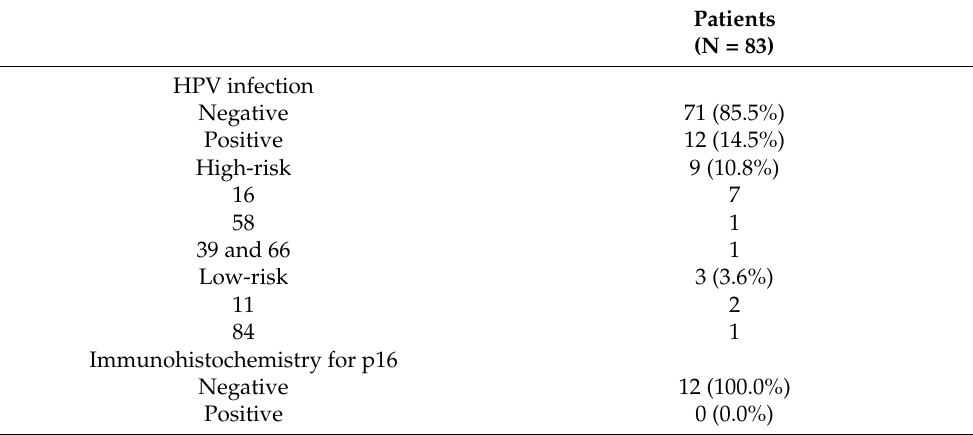
Table 2. Overall prevalence and genotypes of HPV infection in oropharyngeal squamous